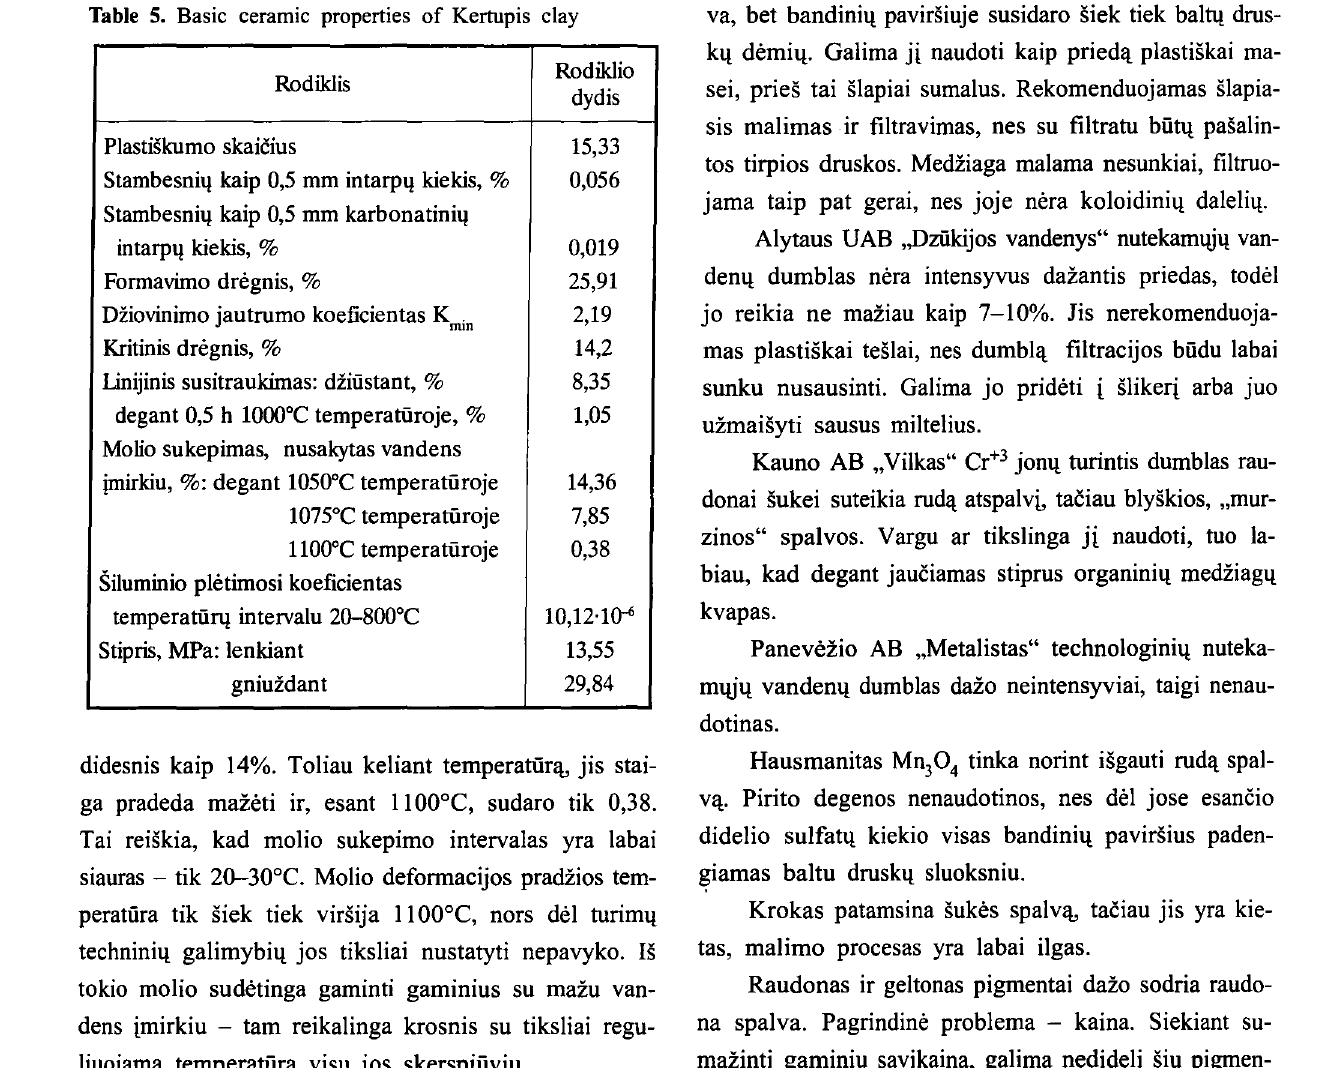
Table 5. Basic ceramic properties of Kertupis clay Rodiklis